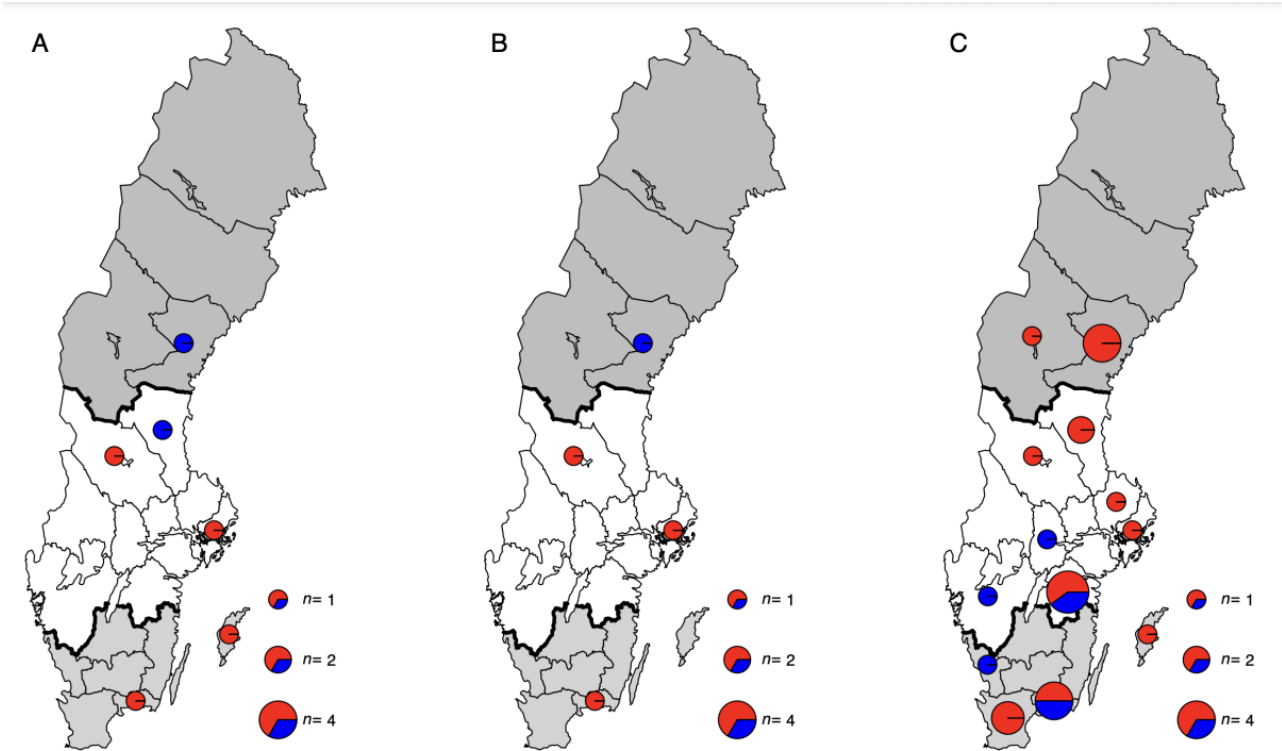
Figure 1. Maps of Sweden showing the locations; North (dark grey), Central (white) and South (light grey), of collected serum samples from goats for analysis of presence of Anaplasma spp. antibodies. The maps show the location and analysis results, positive herds (red) and negative farms (blue), of ( A ) samples collected in 2020, ( B ) samples collected 2019 and ( C ) samples collected from the CAE control programme.